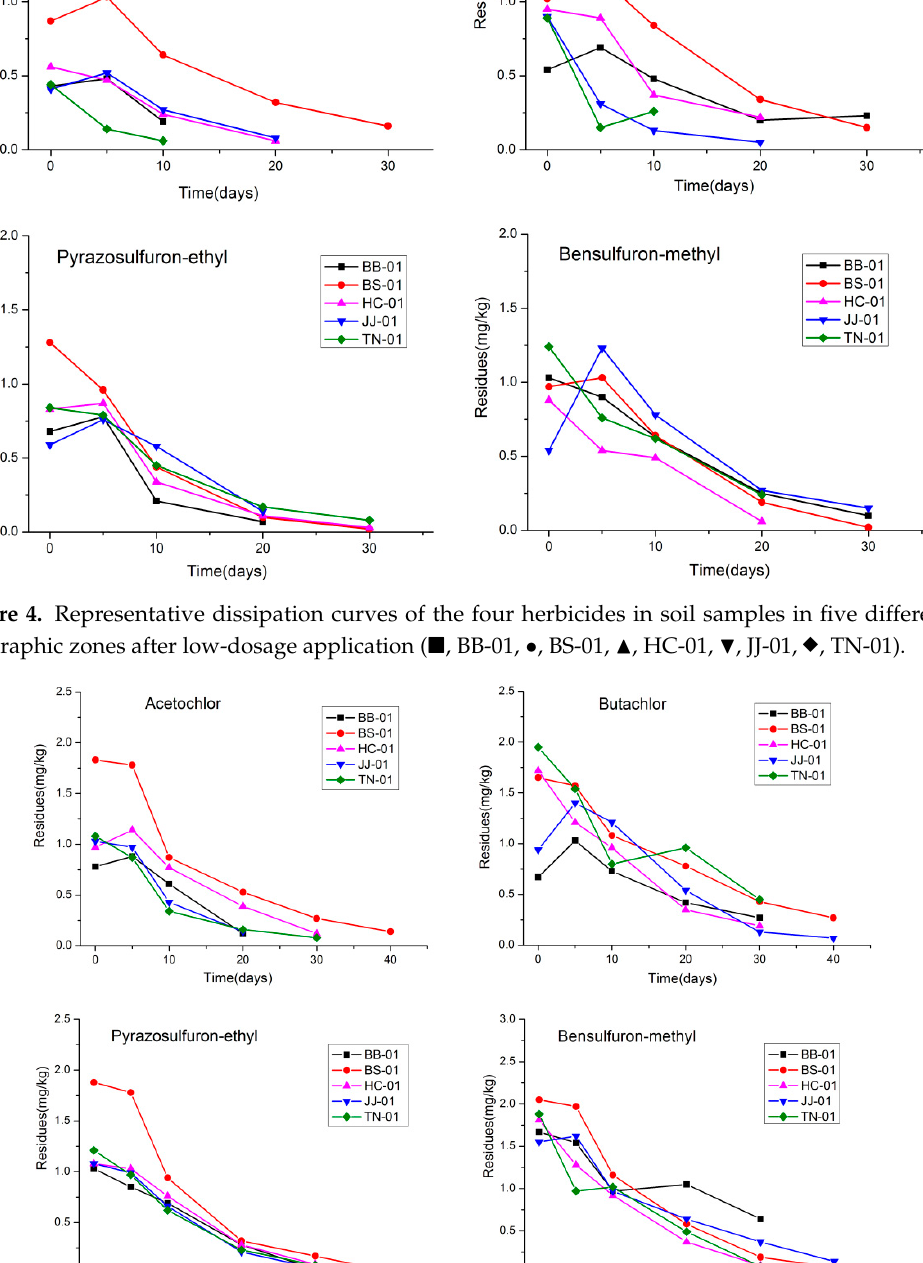
Figure 4. Representative dissipation curves of the four herbicides in soil samples in five different geographic zones after low-dosage application ( ■ , BB-01, ● , BS-01, ▲ , HC-01, ▼ , JJ-01, ◆ , TN-01). Figure 5. Representative dissipation curves of the four herbicides in soil samples in five different geographic zones after high-dosage application ( ■ , BB-01, ● , BS-01, ▲ , HC-01, ▼ , JJ-01, ◆ , TN-01).